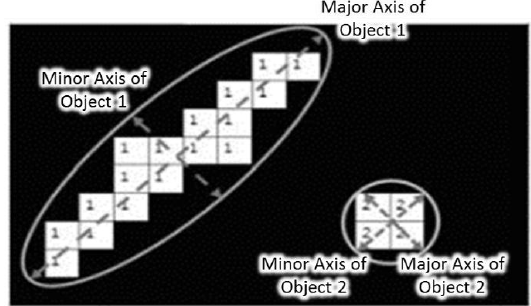
Figure 6. Major and minor axes of objects.